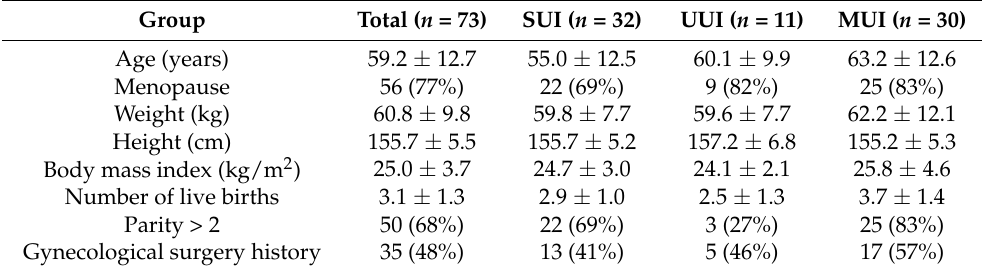
Table 1. Demographic, Anthropometric, and Gynecologic Characteristics of included patients. Group Total ( n =